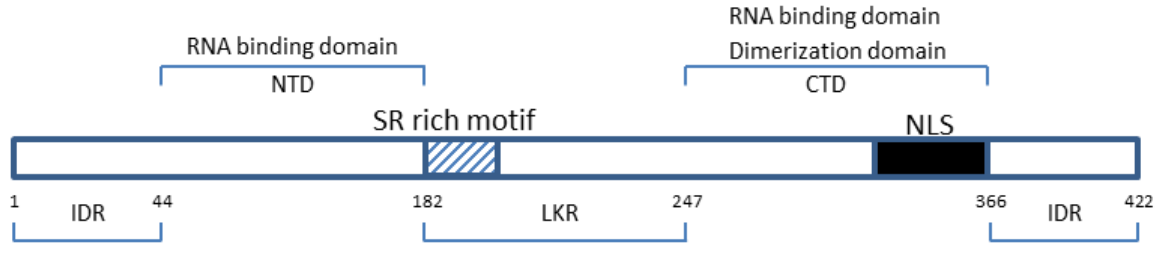
Figure 1. Domain organization of the Severe Acute Respiratory Syndrome human coronavirus (SARS-CoV) nucleocapsid protein. IDR (a.a. 1–44; 182–247; 366–422)— intrinsically disordered regions; NTD (a.a. 45–181)—N terminal domain; LKR (182–247)— linker region; CTD (248–365)—C-terminal domain. The charged SR rich (striated box)